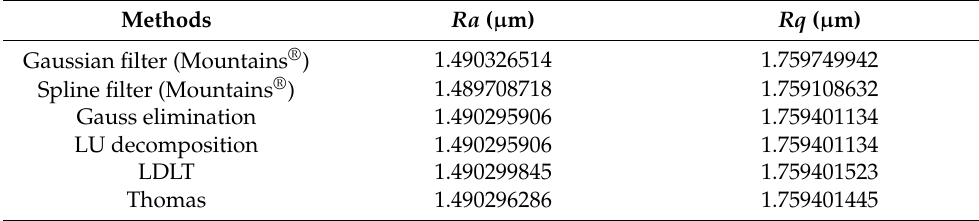
Figure 10. ( a ) Turning profile and ( b ) turning profile without the form deviation. Table 3. Ra , Rq obtained by the Mountains ® software and the four algorithms.